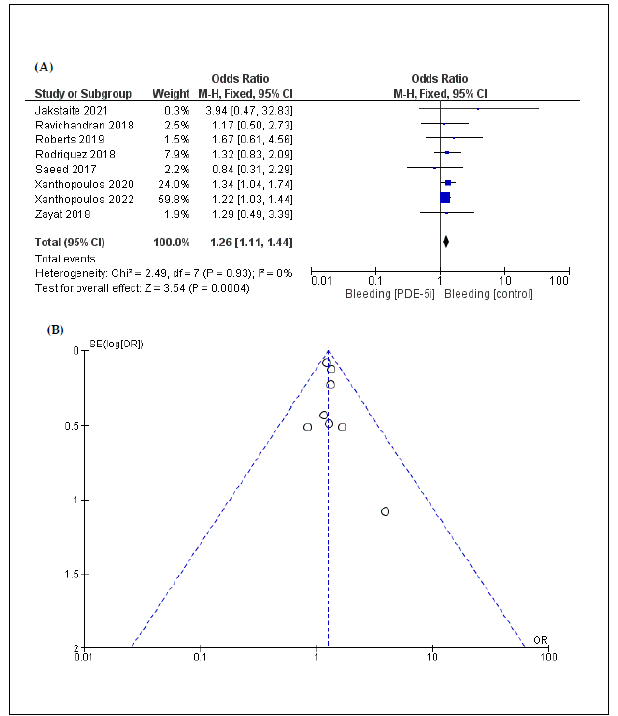
Figure 5. ( A ) Forest plot describing the differences in gastrointestinal bleeding between the 2 groups (PDE ‐ 5i vs. control); ( B ) funnel plot assessing the publication bias for gastrointestinal bleeding